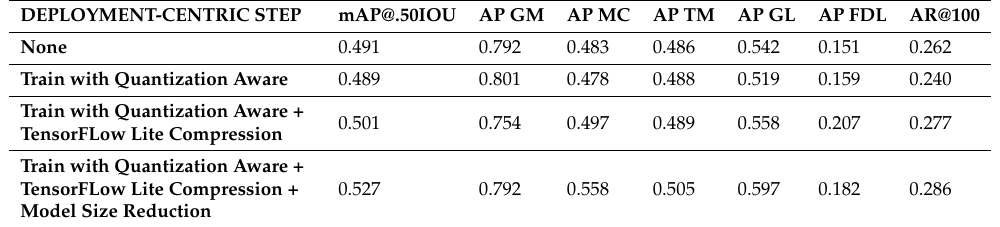
Table 7. Deployment-centric results for Faster R-CNN ResNet101.